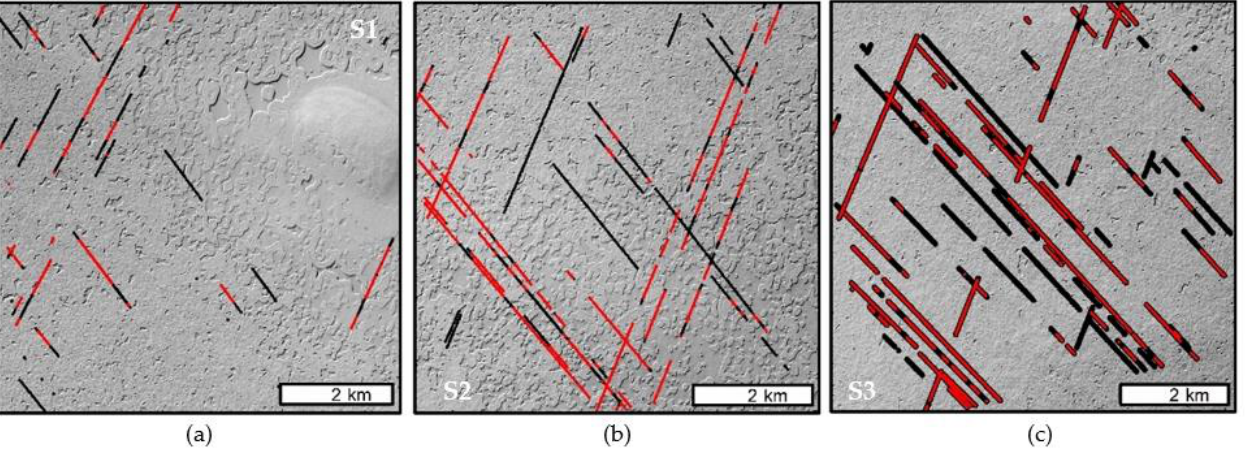
Figure 4. CTX images of three study areas: ( a ) S1; ( b ) S2; ( c ) S3. CTX image B06_012061_0930_XI_87S093W. Red dots represent SHARAD data used for analysis, and the black dots represent SHARAD data that were viewed but not used due to rough surface.